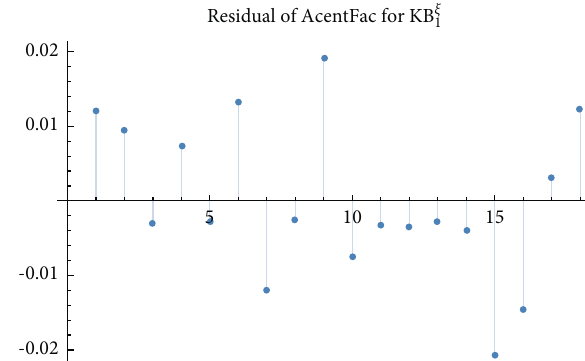
Figure 13: Scatter diagram of AcentFac on GA the fitted regression line.